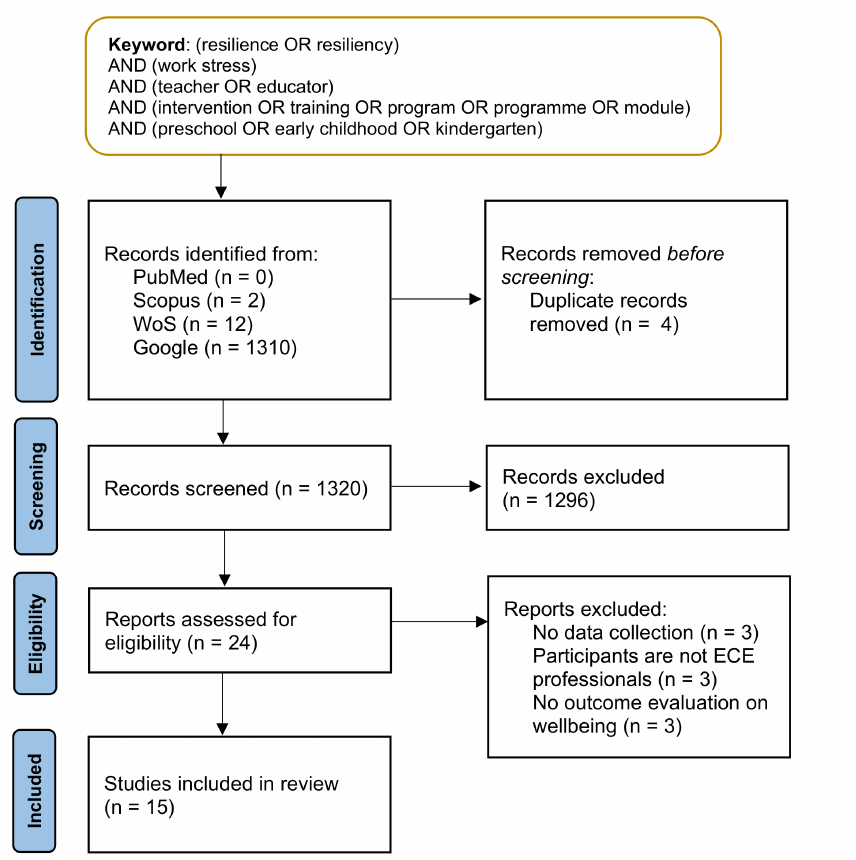
Figure 1. Flow diagram of study selection following PRISMA protocol. Note: ECE—early child- hood